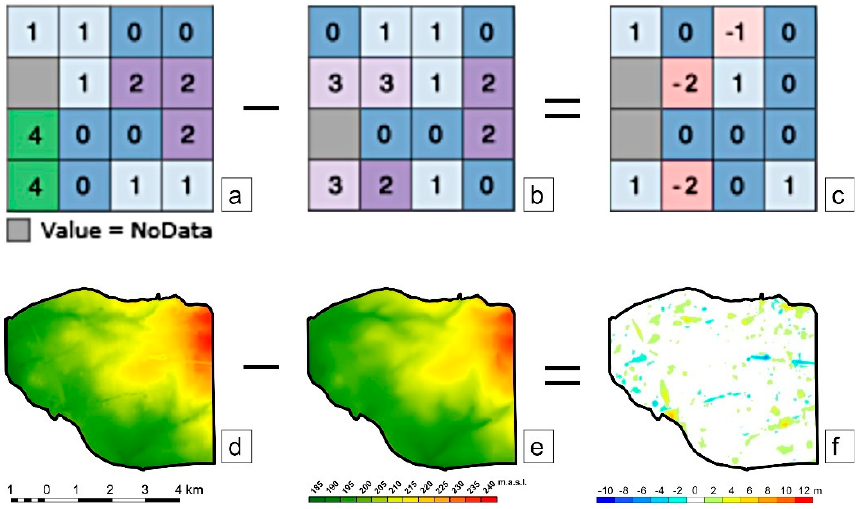
Figure 8. Diagram of how the raster image subtraction function (ESRI 2020) works, using data for Ł ód ź as an example. ( a ) theoretical raster, ( b ) second theoretical raster, ( c ) subtraction result. ( d ) NMT 2017, ( e ) NMT 1917, ( f ) differential model. Source: Own study.